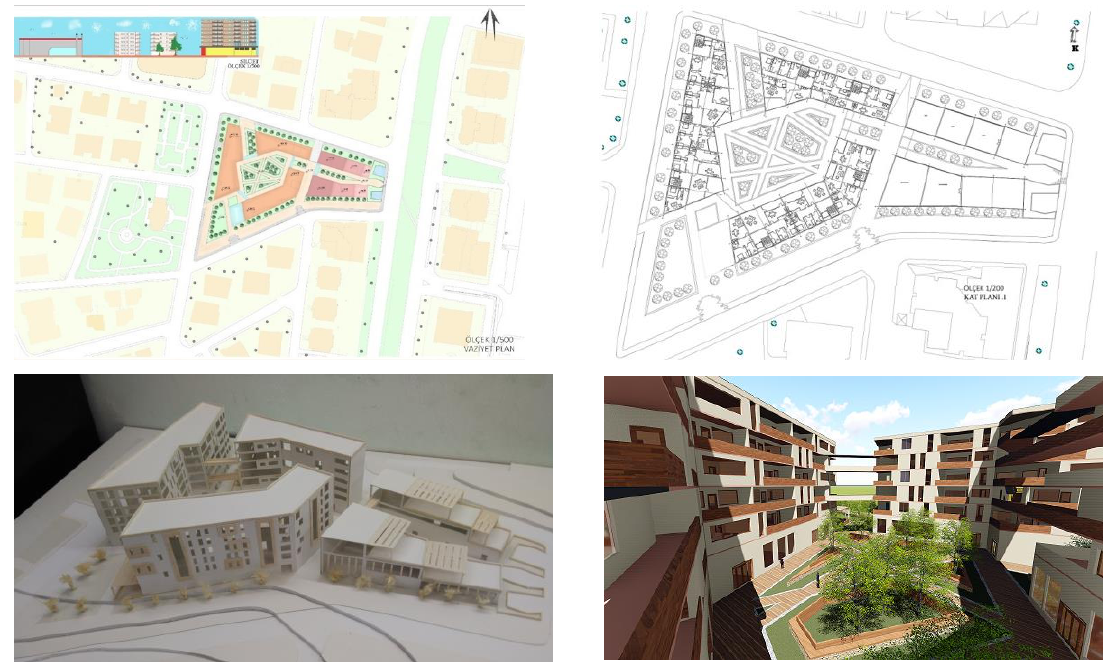
Figure 5. Merlinda Mollavequri- Intersection of